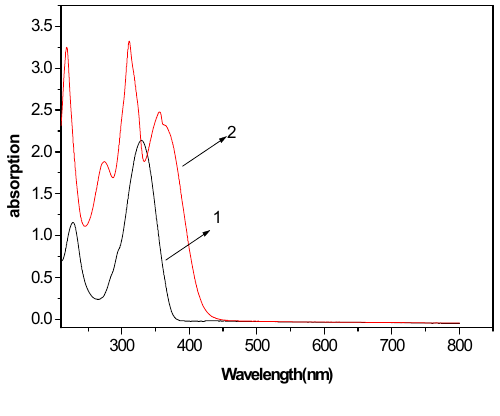
Figure 3. UV-Vis spectra of 1 and 2 .